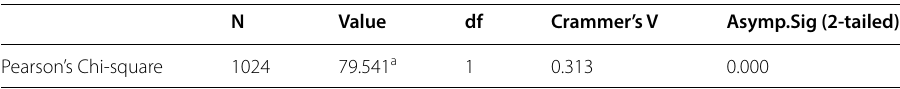
Table 3 Chi-square tests